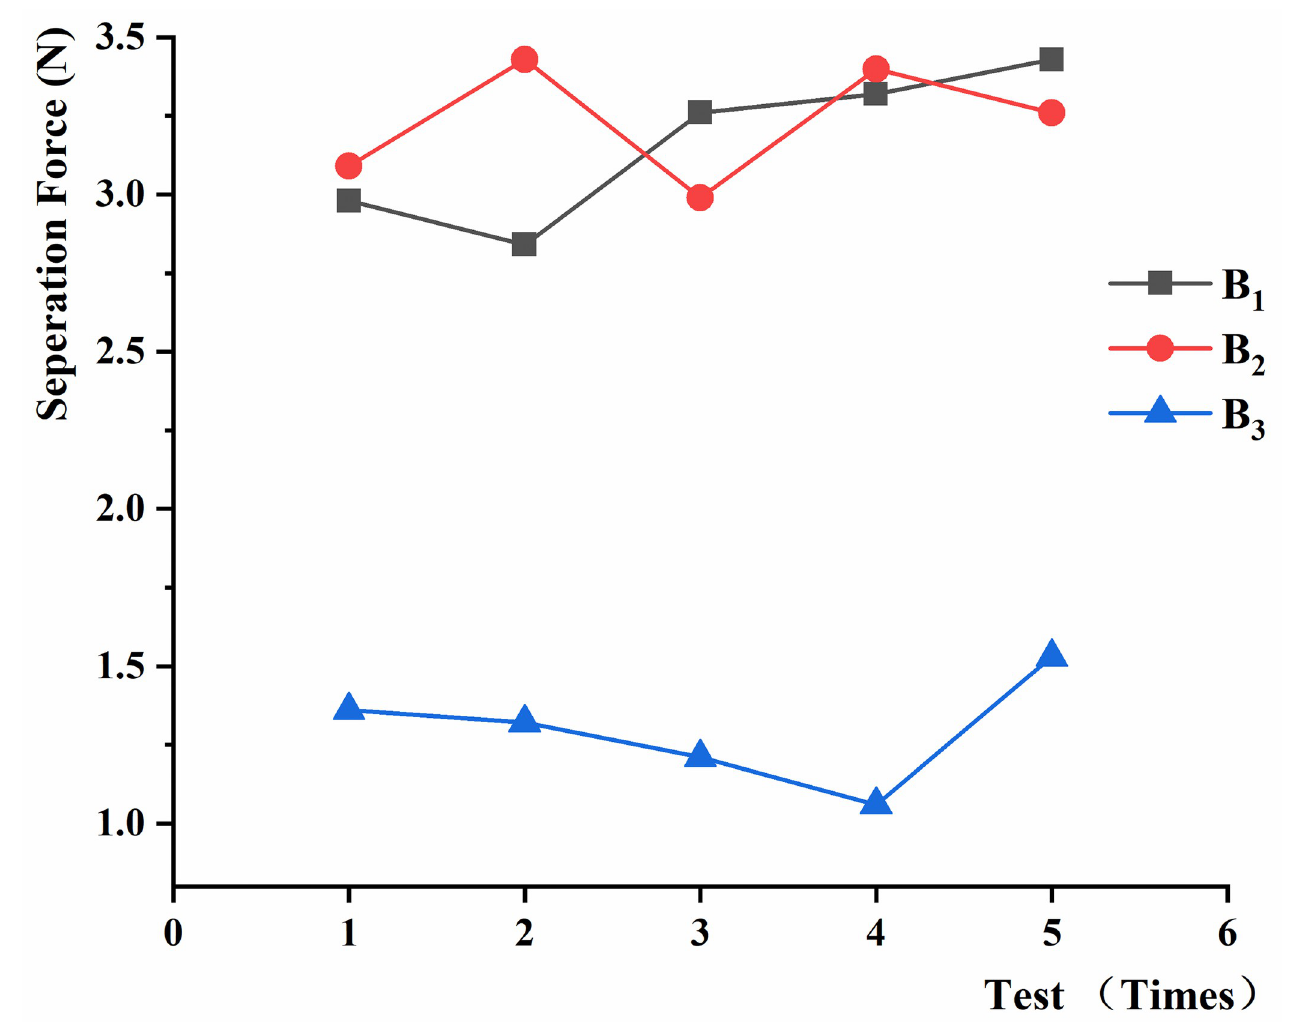
Fig 13. Separation force between the sticks and black fungus of different